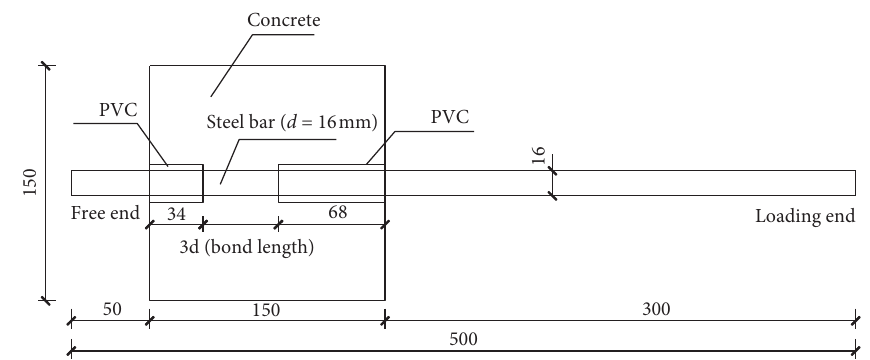
Figure 3: Pull-out test specimen (all units in millimeters, d is the rebar diameter).